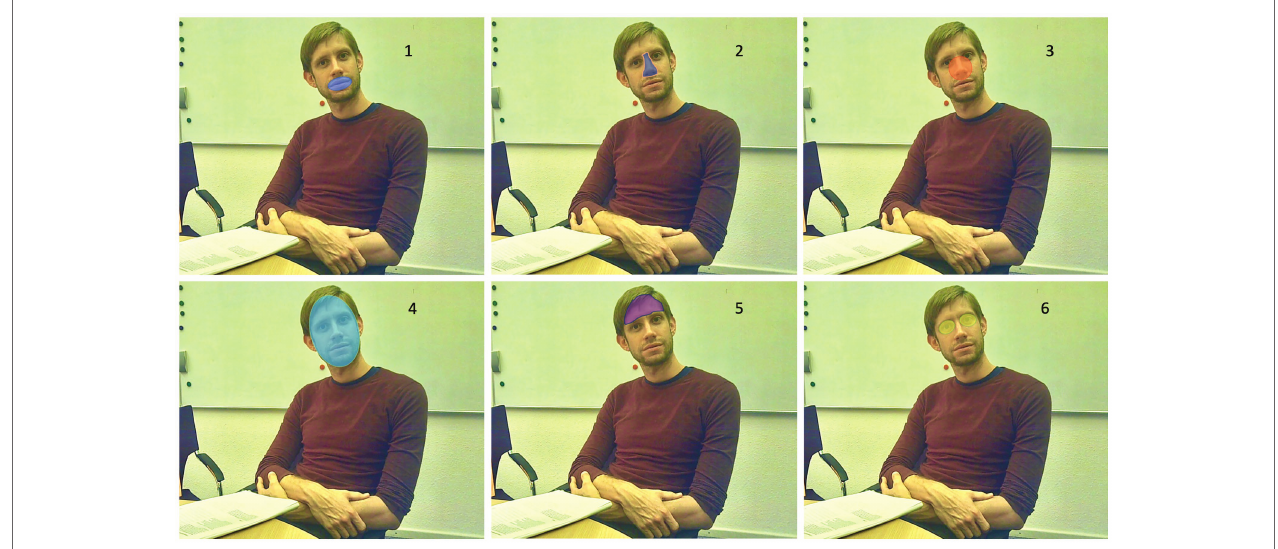
FIGURE 2 | Illustrative example of the main AOIs: 1. MOUTH, 2. NOSE, 3. CENTER-FACE, 4. FACE, 5. FOREHEAD, and 6.